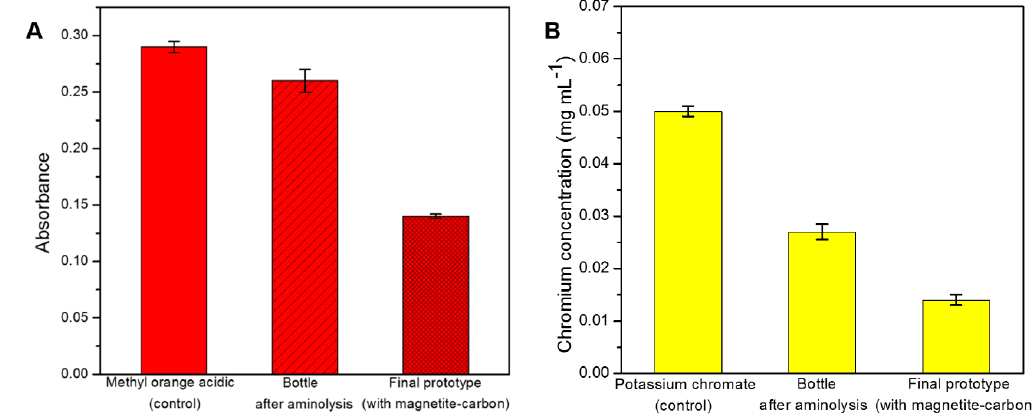
Figure 6. Efficacy of the modified bottle prototype for the removal of ( A ) acidic methyl orange and ( B ) hexavalent chromium from water. The data are the average of three measurements on three different prototypes.